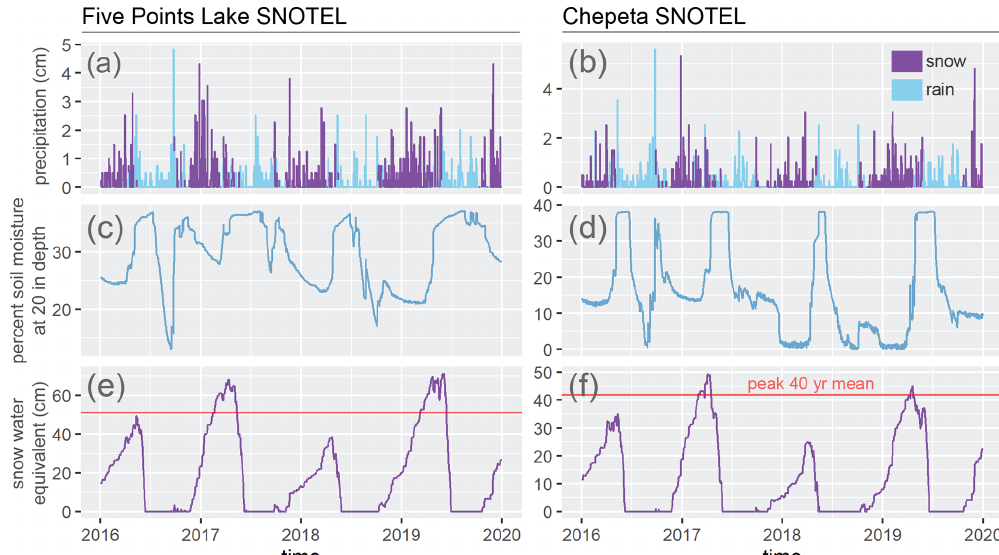
Figure 9. Precipitation, soil moisture, soil temperature, and snow water equivalent (SWE) at the Five Points Lake and Chepeta SNOTEL stations from 2016 to 2019. (a, b) Precipitation events. Purple lines represent snow, and blue lines represent rain. Precipitation type was inferred from average daily temperature at the SNOTEL station. (c, d) Percent soil moisture at 20in (50.8cm) depth. (e, f) SWE. Red lines represent average peak SWE over the past 40